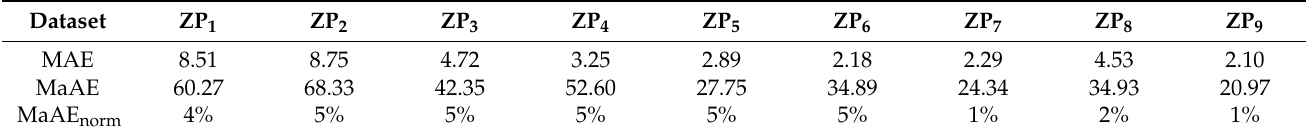
Table 1. Simulation results with the SARIMA algorithm for ZP sets 1 . . . , ZP 9 .